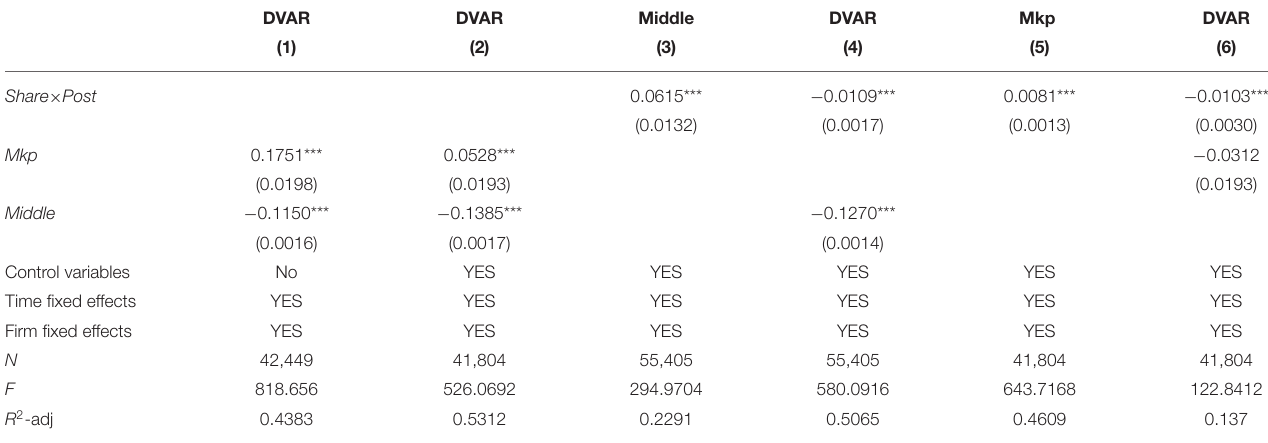
TABLE 6 | Influence mechanism